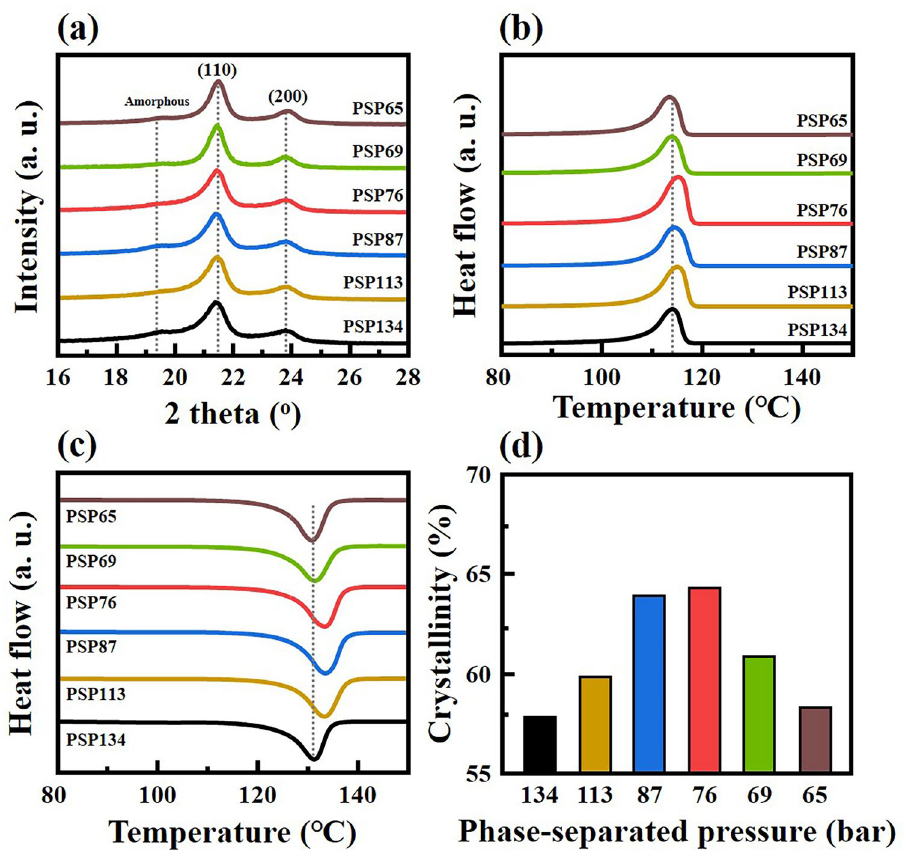
Figure 6. Characterization results for FSFs obtained at different PSPs. ( a ) XRD patterns, ( b , c ) DSC curves, and ( d ) crystallinity of FSFs obtained via DSC